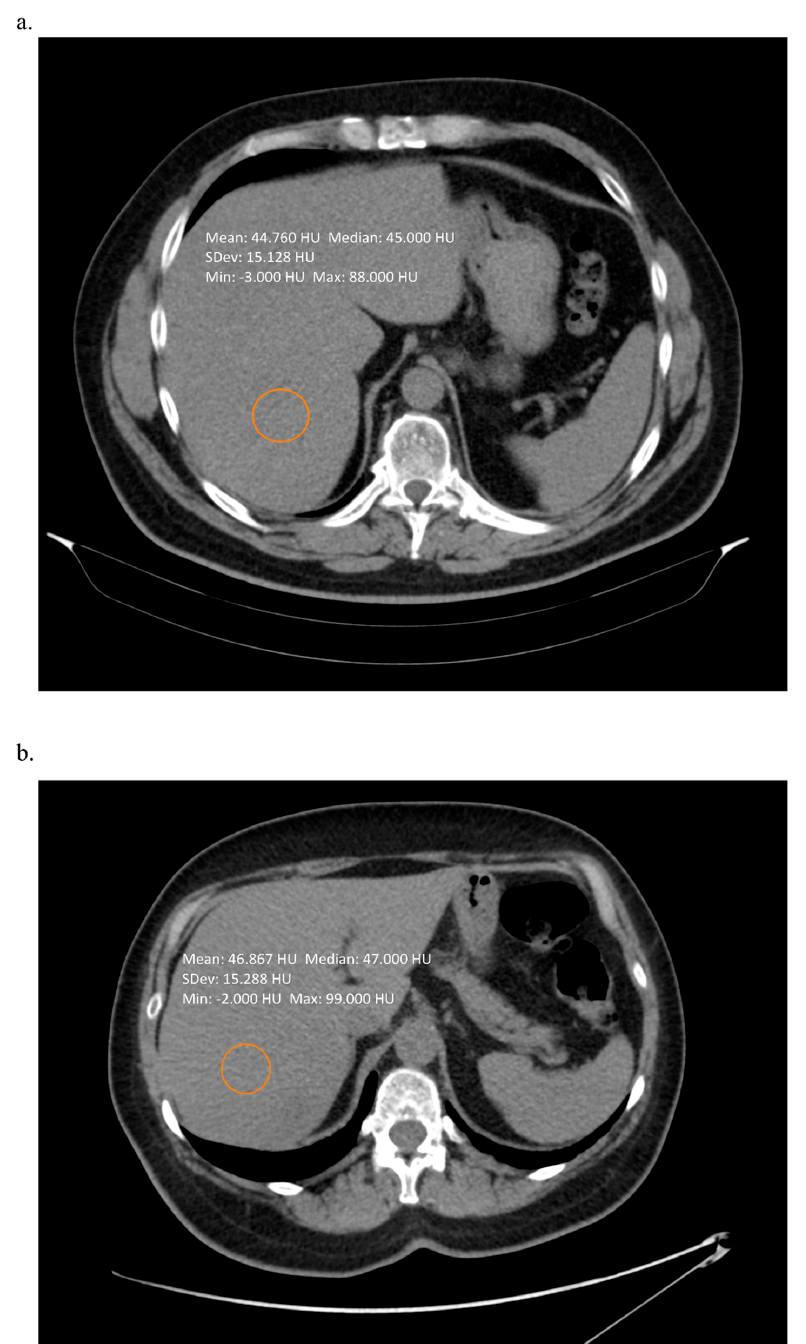
Figure 2. Non-contrast enhanced computed tomography scan of a patient with ( a ) 60% of hepatic steatosis ( b ) 80% of hepatic steatosis. In both cases simple measurement of the liver density was not suggestive on such severe changes. Images from the authors’ department.